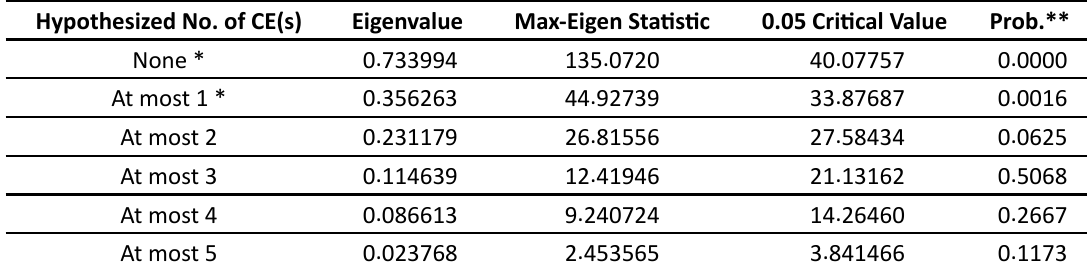
Table 5: Johansen Cointegration Test Results (Max-Eigen Statistic) Hypothesized No. of CE(s) Eigenvalue Max-Eigen Statistic